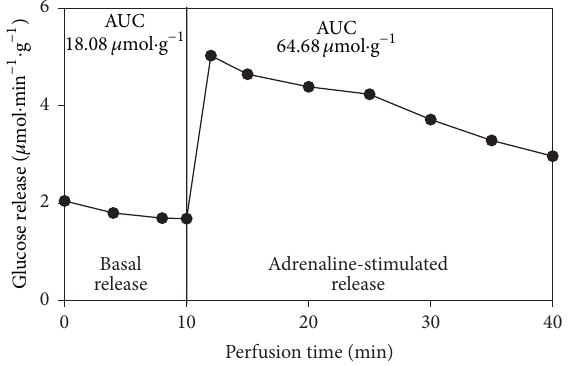
Figure 1: Illustrative graph of liver glucose release in a fed control rat, before (basal release) and during (stimulated release) perfusion with adrenaline (1 𝜇 M). The vertical line indicates the transition from basal perfusion (KH only) to stimulated perfusion (KH with adrenaline 1 𝜇 M). The AUC of basal glucose release considered all glucose released during the 10-min interval. AUC of stimulated release considered those glucose values above the basal release during the 30-min